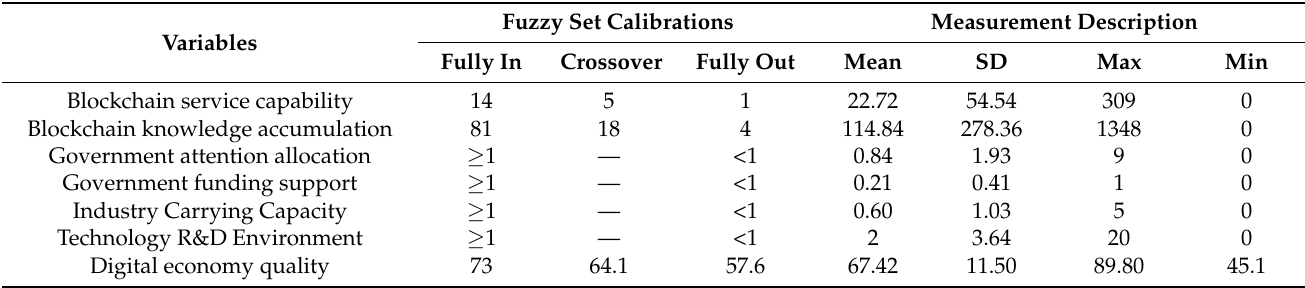
Table 3. Fuzzy-set membership calibrations and sample